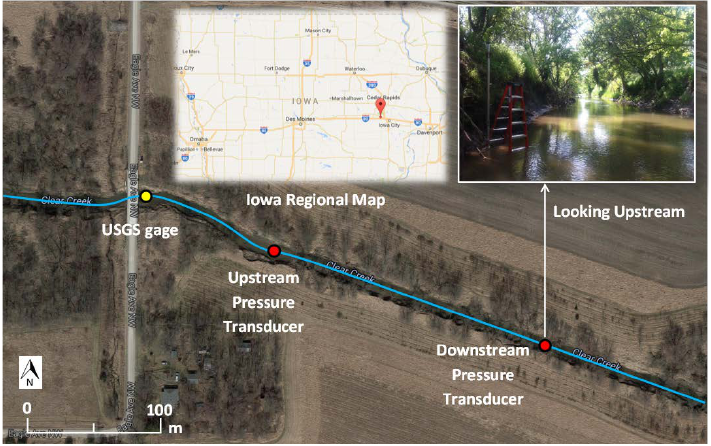
Figure 1. Study area demonstrating a pair of pressure transducer locations at the USGS site (05454220) on Clear Creek near Oxford (Iowa, USA). Inset Iowa regional map showing the site location and the background image are provided by Google